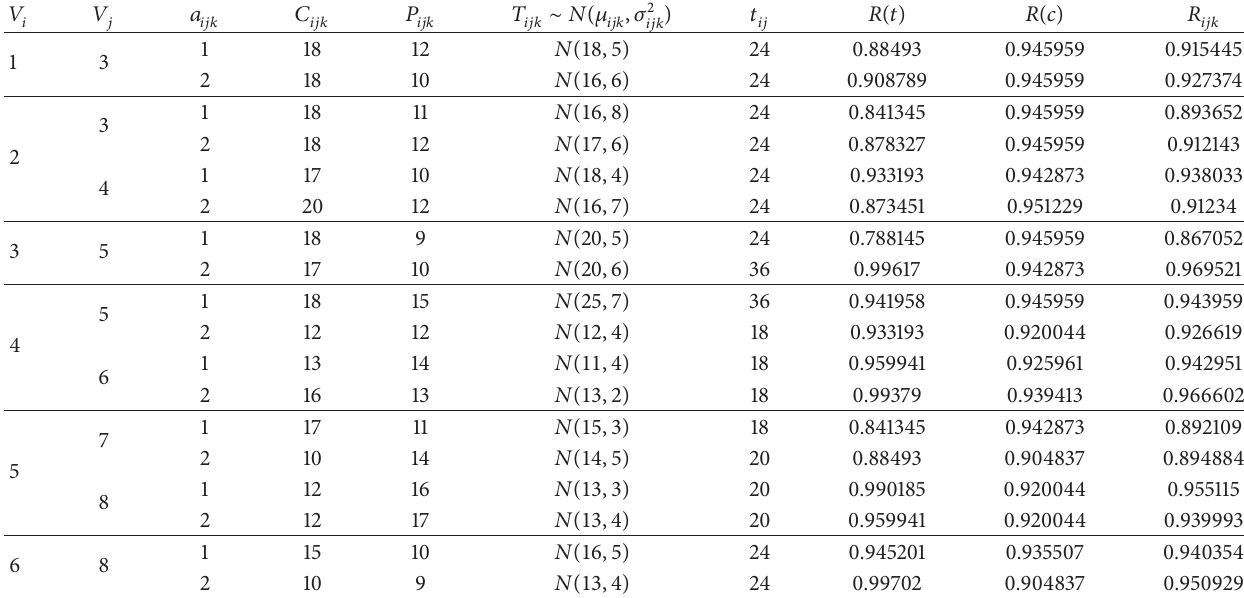
Table 2: The data of arcs for the 8-node problem.